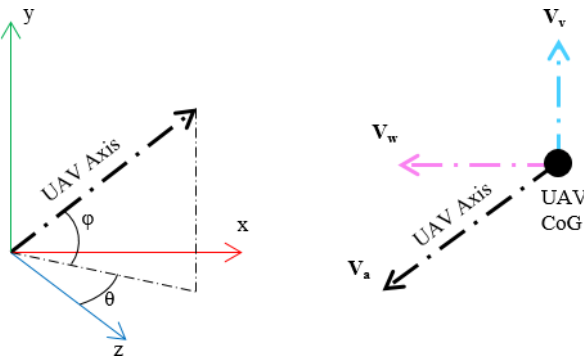
Figure 9. An illustration clarifying the angle and velocity variable definitions used for the computation of